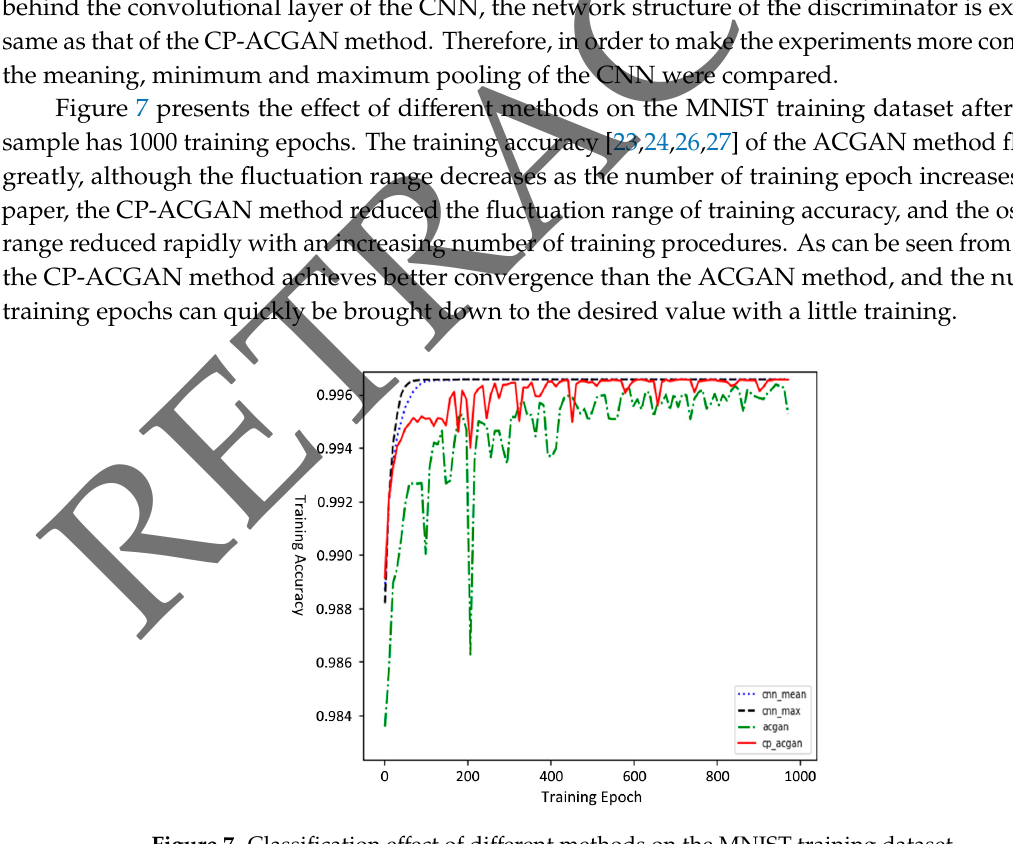
Figure 7. Classification effect of different methods on the MNIST training dataset.